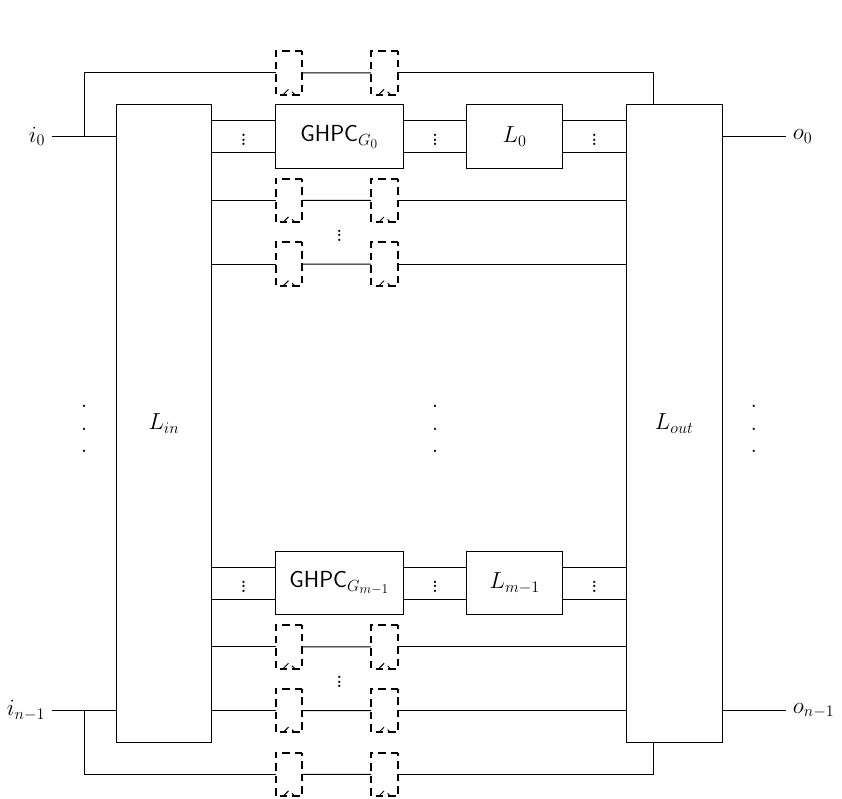
Figure 6: Generic structure of a masked circuit after applying the ANF processing method. Dashed registers are optional but necessary to make a pipelined